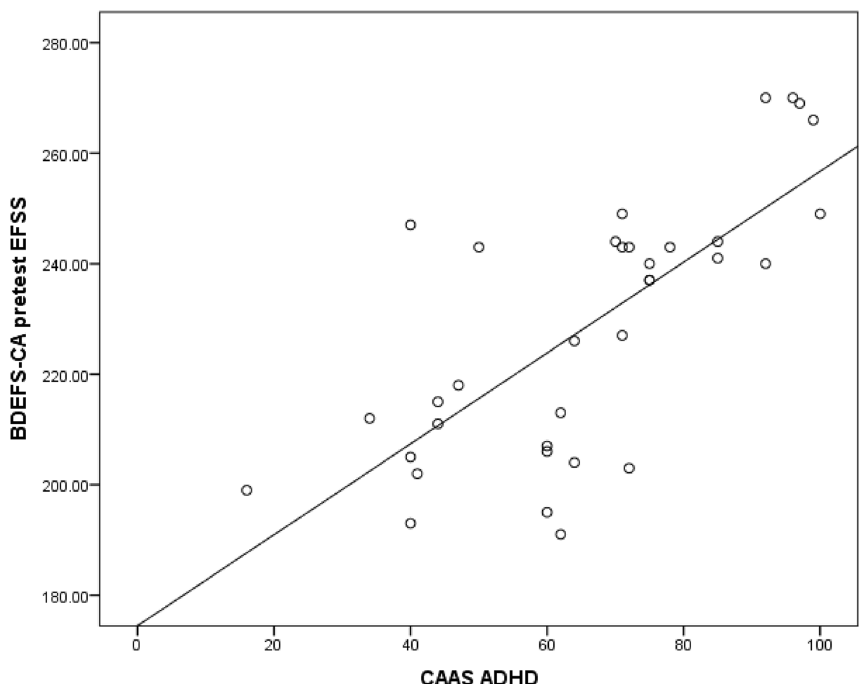
Fig. 1 Correlation between BDEFS‑CA pretest EFSS and CAAS ADHD